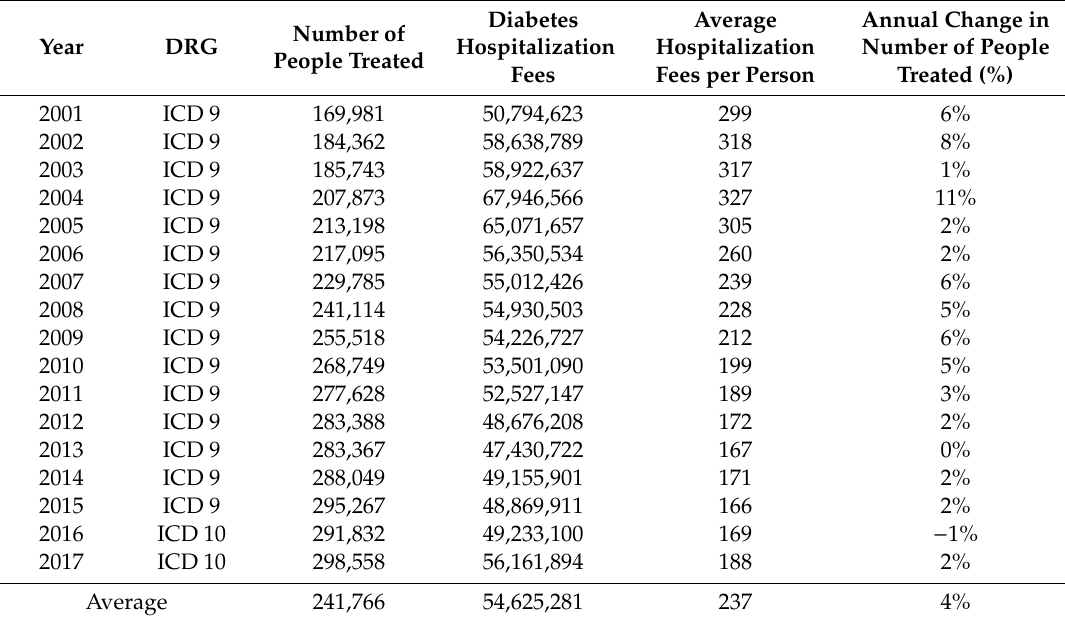
Table 1. Hospitalization fees and number of people treated for diabetes in 2001–2017 under the global payment for Department of Health Insurance (DHI) (USD). Diabetes Average Annual Change in Number of DRG Hospitalization Hospitalization Number of People Treated Fees per Person